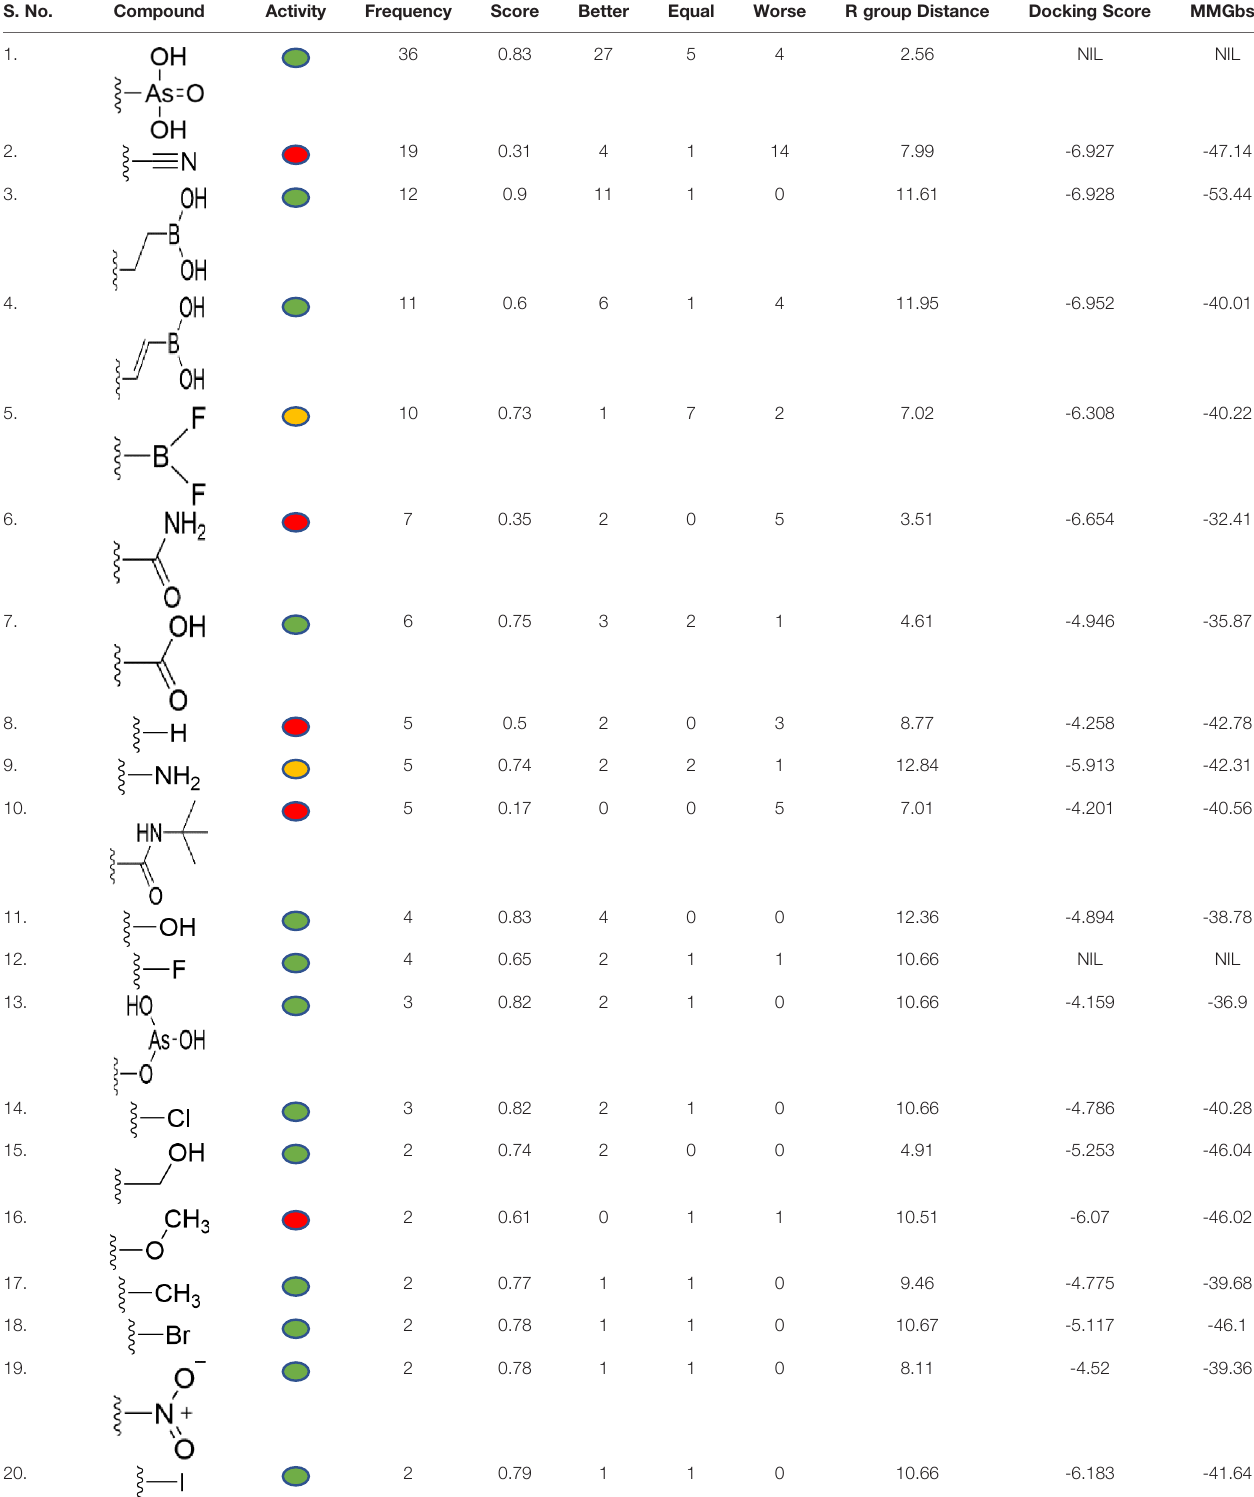
TABLE 1 | Identi fi cation of lead compound through screening of small molecules based on docking and activity scores. S.